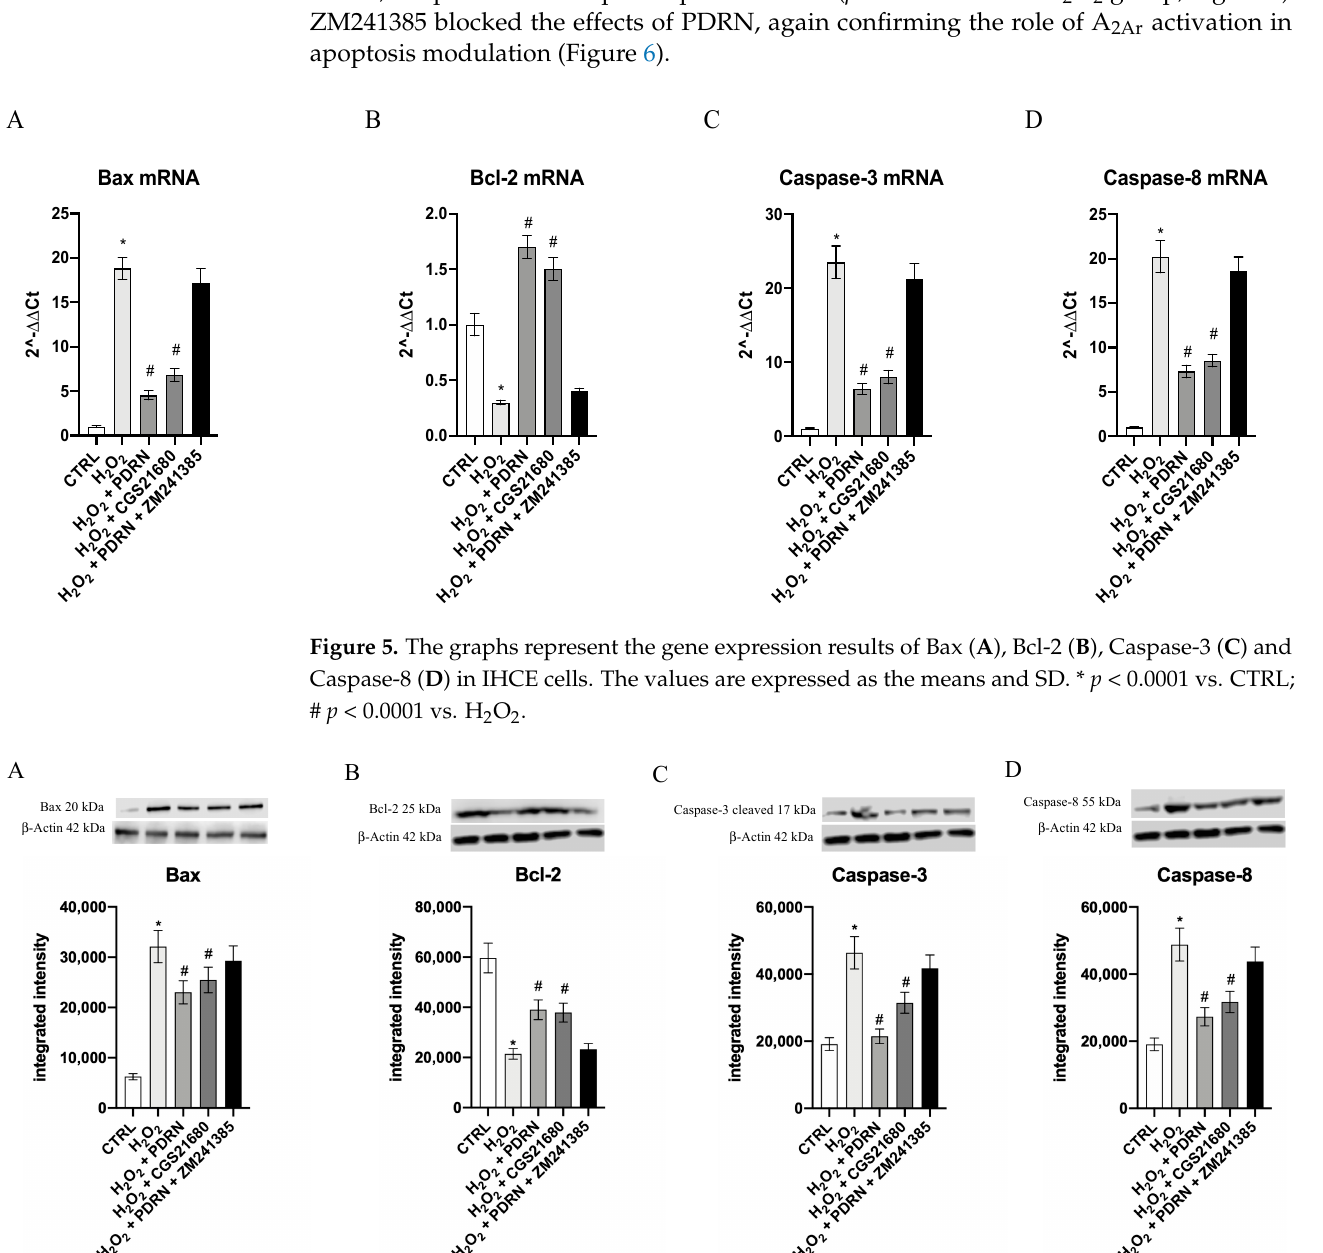
Figure 6. The graphs represent Bax ( A ), Bcl-2 ( B ), Caspase-3 ( C ) and Caspase-8 ( D ) protein expression in IHCE cells. The values are expressed as the means and SD. * p < 0.0001 vs. CTRL; # p < 0.0001 vs. H 2 O 2 .